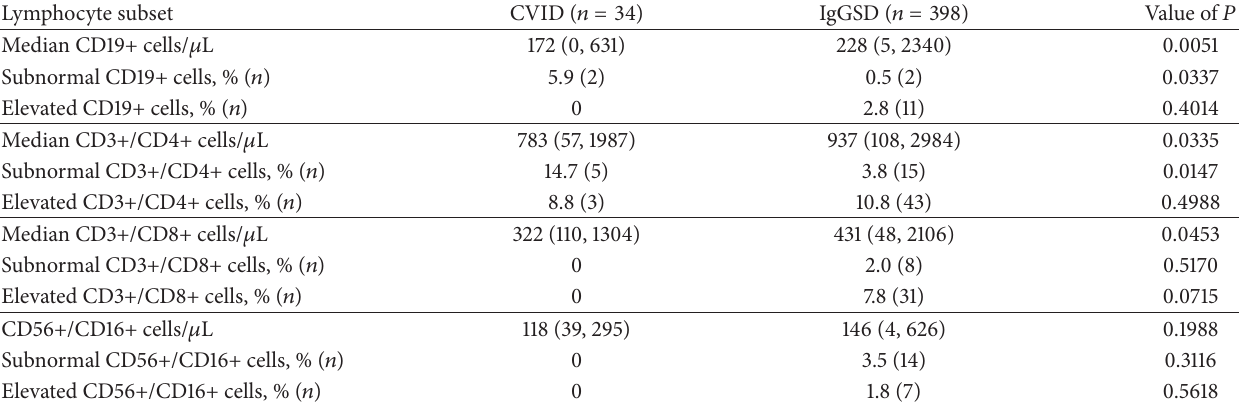
Table 4: Blood lymphocytes in 432 adult CVID/IgGSD index patients 1 .